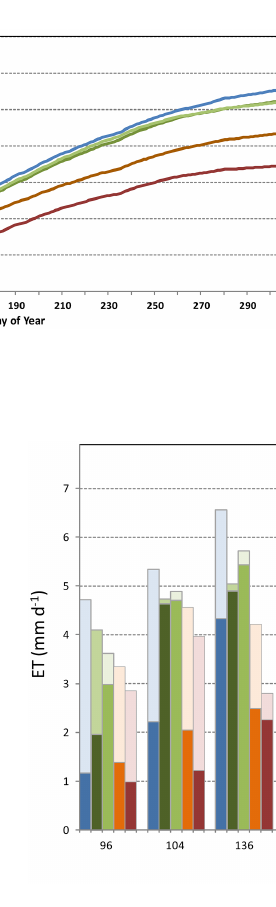
Figure 15. Average evaporation ( E ) and transpiration ( T ) compo- nents of ET for five land cover types on Landsat overpass